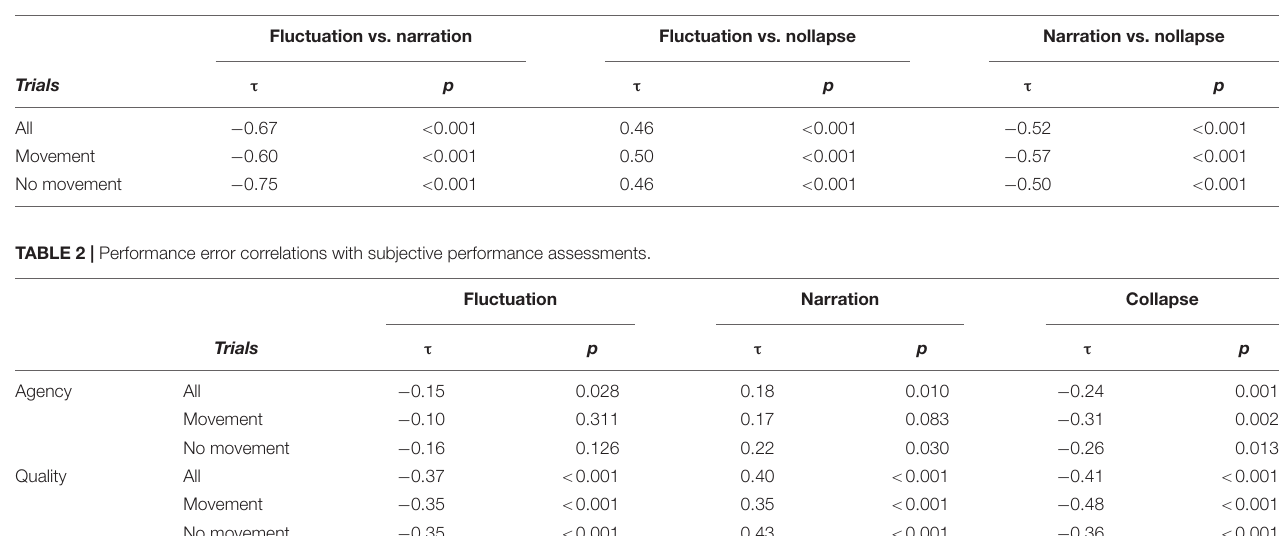
TABLE 1 | Performance error correlations.